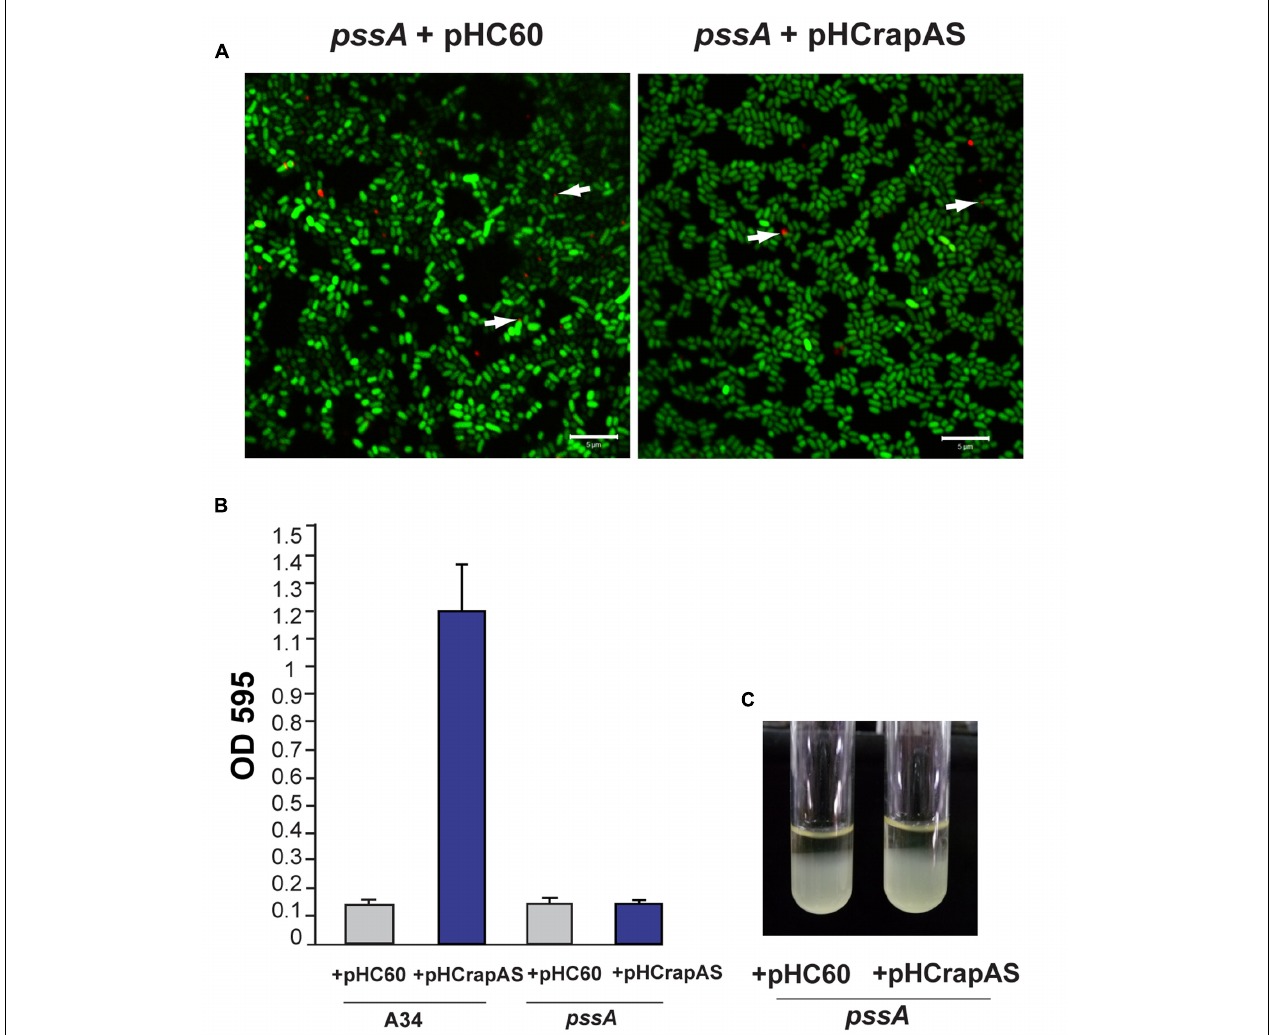
FIGURE 6 | RapA-associated phenotypes are dependent on CPS (capsular polysaccharide)/EPS (extracellular polysaccharide) synthesis. (A) IF images of GFP-labeled pssA strains (green) harboring pHC60 or pHCrapAS using anti-RapA2 antiserum and Cy3-labeled secondary antibody (red) were acquired using a Plan-Apochromat 100x/1.4 Oil Objective from a CLSM. Arrows indicate polar localization of RapA. White bar: 5 µ m. (B) Adhesion to polystyrene of bacteria grown in Y-minimal medium. At least three independent experiments were conducted with six replicate wells per experiment, the error bars indicate one standard deviation. (C) Bacterial sedimentation in Y-minimal medium cultures. R. leguminosarum strains harboring either pHC60 or pHCrapAS were left standing for 10